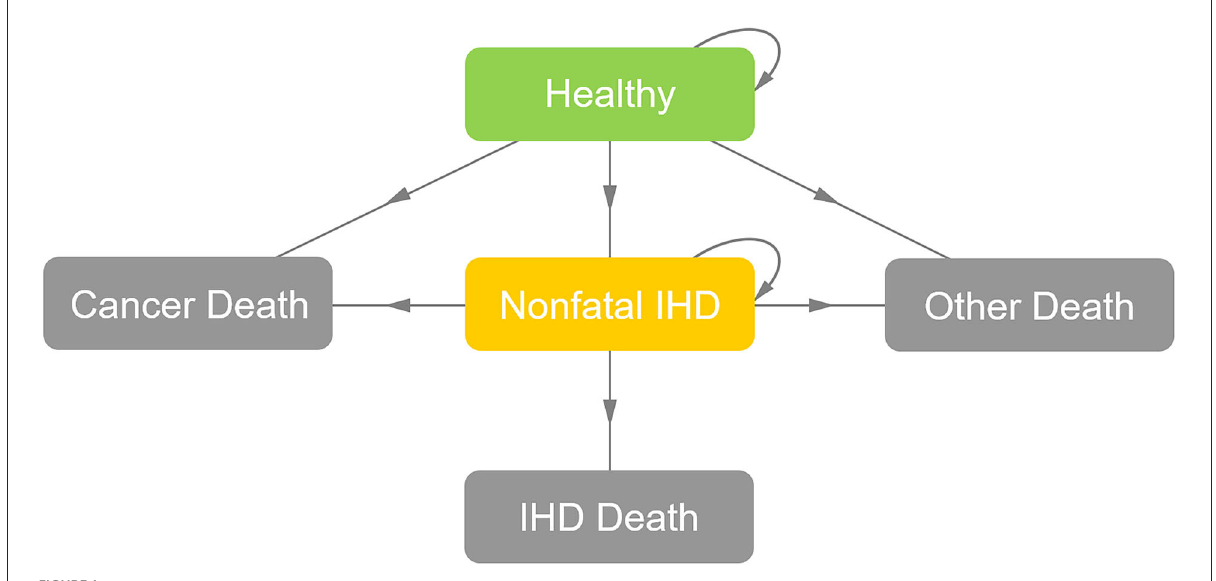
FIGURE1 General structure of the Markov model. After radiotherapy, the patient might be in a state of “healthy,” “nonfatal IHD,” or “death” (“IHD death,” “cancer death,” or “other death”). For each cycle, if the patient was in the state of “healthy,” she might stay in the state of “healthy,” develop into the state of “non-fatal IHD” or develop into the “death” states; if the patient was in the state of “non-fatal IHD,” she might stay in the state of “non-fatal IHD” or develop into the “death” states; and if the patient was in the absorbing “death” states, the loop operation would be terminated. IHD, ischemic heart